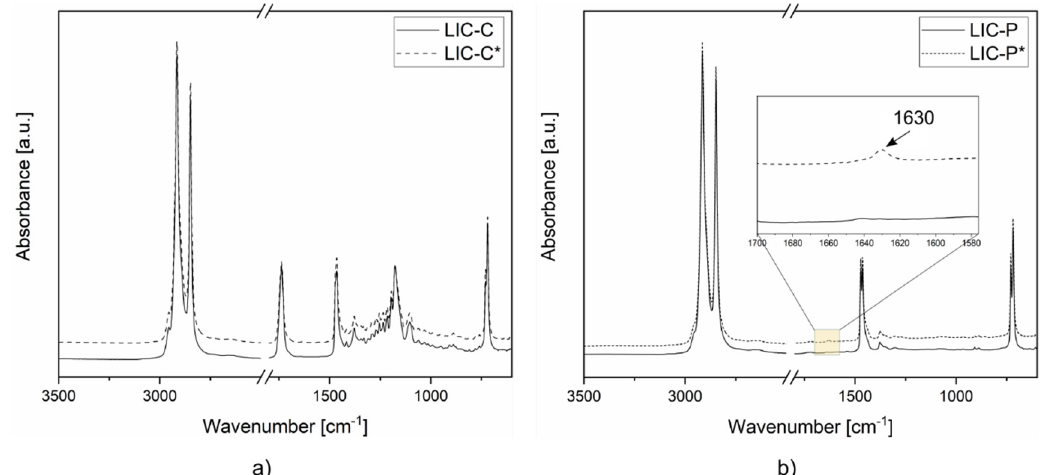
Figure 5. FTIR spectra of lubricated icephobic coatings: ( a ) LIC-C and LIC-C*, and ( b ) LIC-P and LIC-P*. The spectra region is highlighted by a yellow box when chemical modifications are detected.